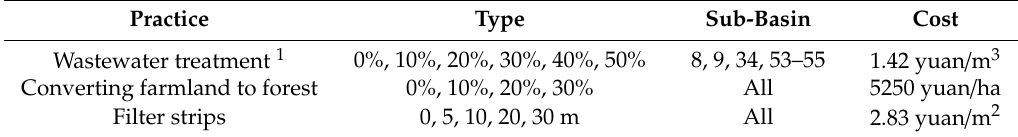
Table 2. Cost information and type of practices in the optimization.